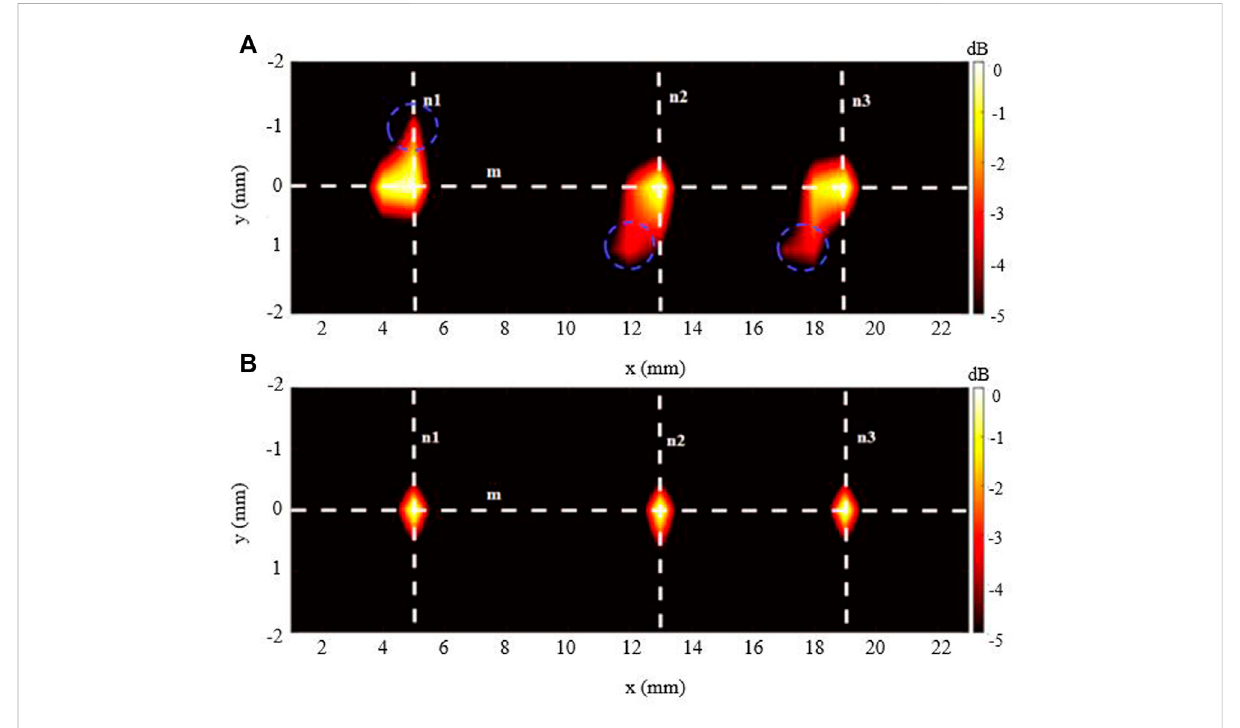
FIGURE 9 Imaging result of the 3-source with (A) DAE and (B) aDAF (hot colors, 5-dB dynamic